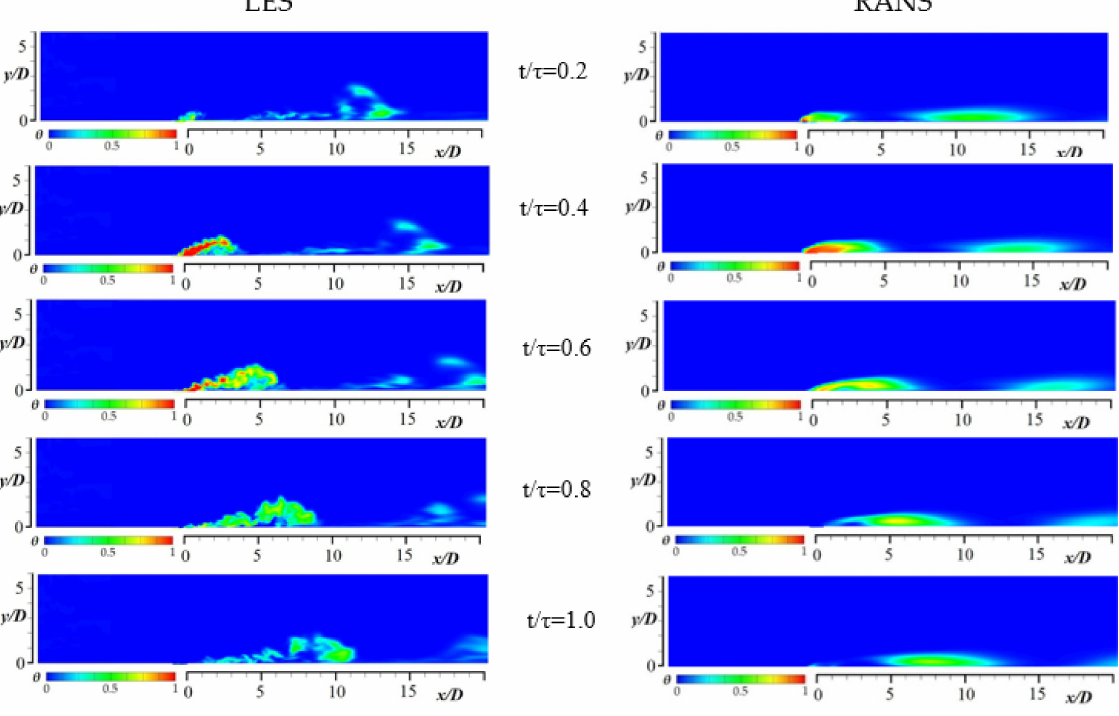
Figure 12. Instantaneous dimensionless temperature contours for the 30 ◦ orientation angle on the spanwise-normal plane of z/D = 0.425 for the 36 Hz flow